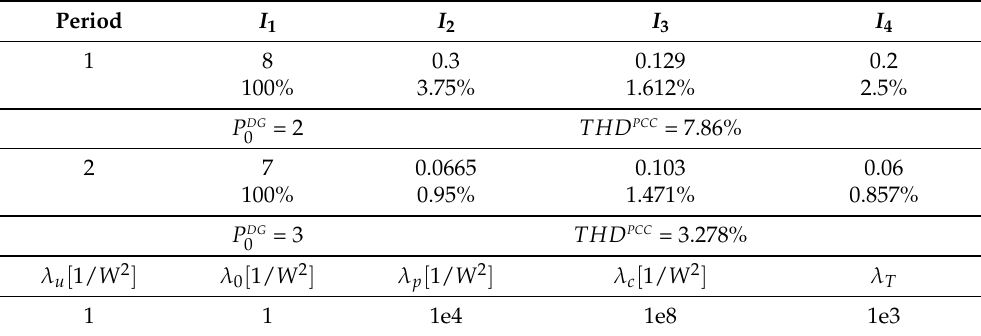
Figure 9. Power delivered by the DG for harmonics compensation. Table 6. Measured currents and weighting